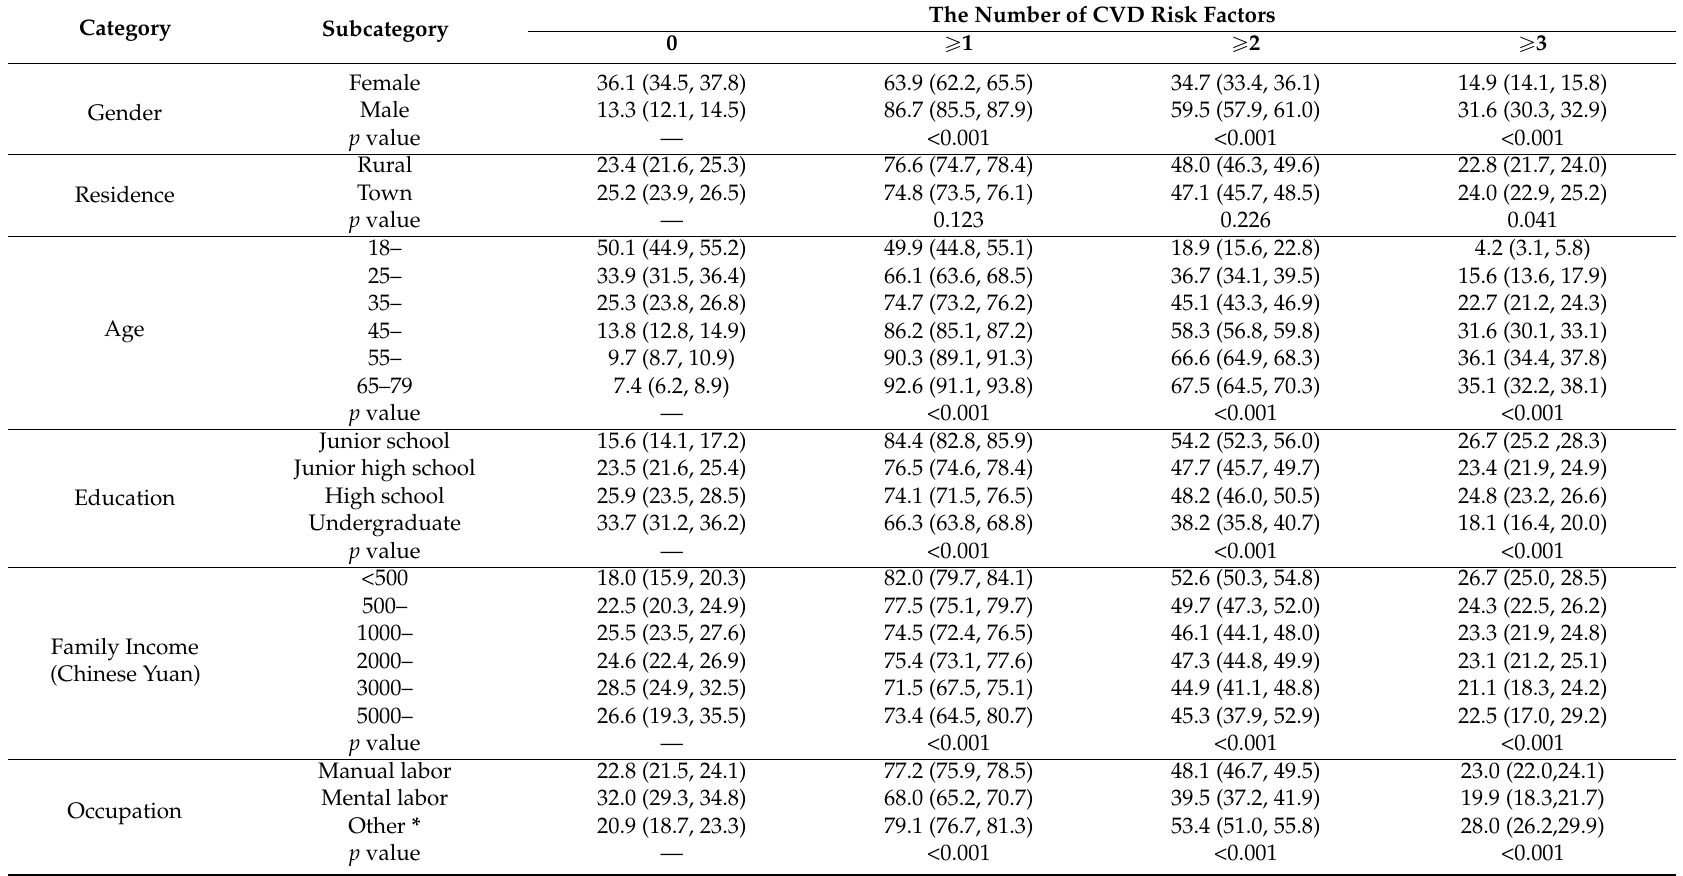
Table 4. Prevalences with different numbers of CVD risk